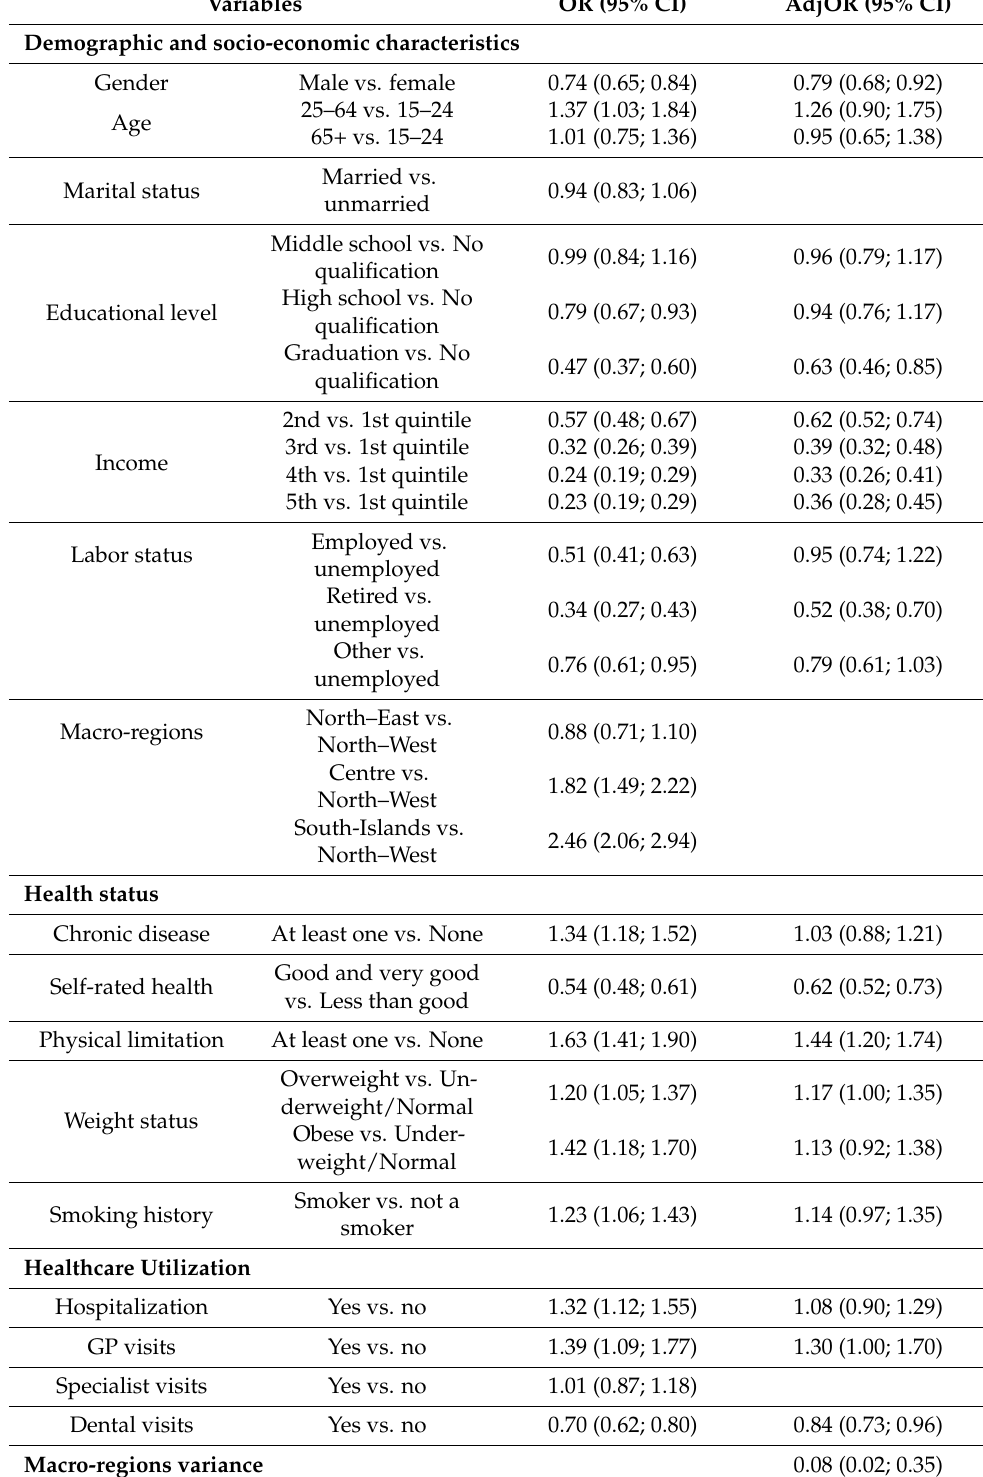
Table 4. Not performing exams since they are very expensive related to socio-economic and health characteristics of respondents: Univariable and multivariable